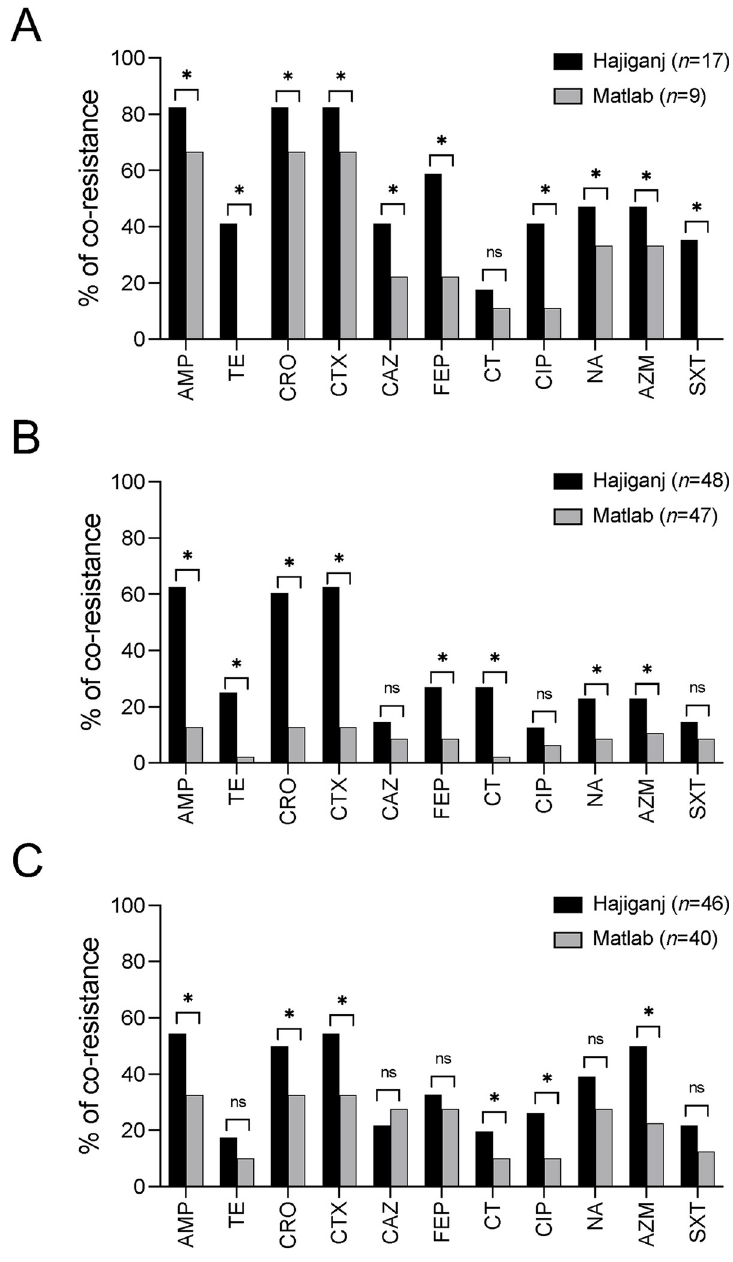
Fig 3. Co-occurrence of arsenic and antibiotic resistance in extended-spectrum β -lactamase (ESBL)-producing E . coli isolates. Co-resistance to arsenic and antibiotic resistance of ESBL E . coli isolates in A) drinking water, B) mother stool, and C) child stool samples in Hajiganj (high arsenic exposure) and Matlab (low arsenic exposure) was determined by selecting bacterial isolates that showed resistance to any of the third-generation cephalosporin antibiotics (CRO, ceftriaxone, CTX, cefotaxime; CAZ, ceftazidime; FEP, cefepime) and were arsB gene positive by PCR assays. ‘ n ’ indicates the number of third-generation cephalosporin-resistant bacterial isolates for each group of samples. AMP, ampicillin; TE, tetracycline; CRO, ceftriaxone, CTX, cefotaxime; CAZ, ceftazidime; FEP, cefepime; CT, colistin; CIP, ciprofloxacin; NA, nalidixic acid; AZM, azithromycin; SXT, trimethoprim-sulfamethoxazole. The asterisks indicate significance ( � p < 0.05).